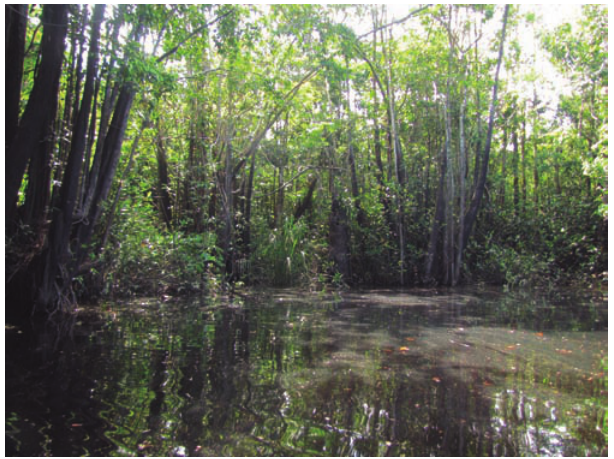
Fig. 6. Lake at right bank of rio Urubaxi, near igarapé Tapage, rio Negro, the type locality of Priocharax nanus . Photograph by Manoela M. F.